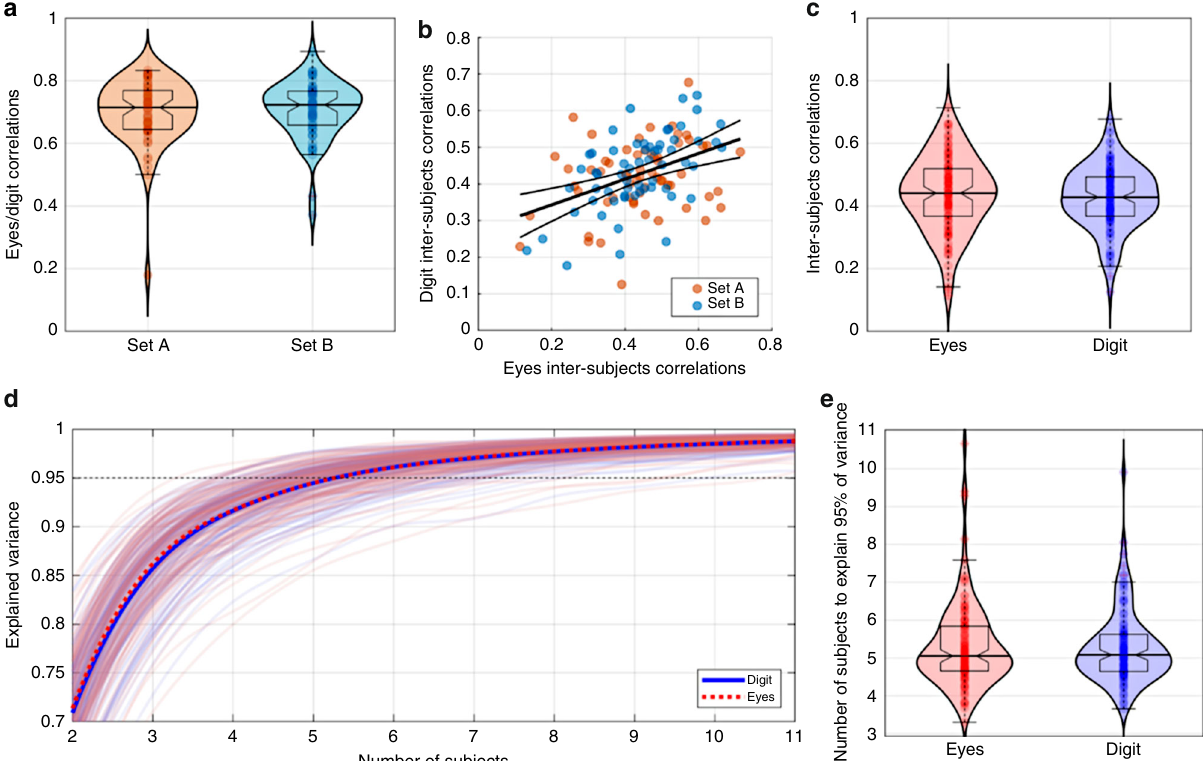
Fig. 2 Digit and eye-tracking comparison. A total of 122 pictures featuring humans, animals, objects or abstract art were divided in two sets (Set A and Set B). Half of the subjects explored Set A using digit-tracking and Set B with eye-tracking, while the other half explored Set B using digit-tracking and Set A using eye- tracking, thus yielding two independent sets of attention maps for each method. a Violin plots of the Pearson ’ s correlation coef fi cients calculated, for each picture, between the probability density estimates of exploration measured with eye-tracking or digit-tracking (11 subjects/condition). Both techniques can measure precise attention maps that are highly correlated (Set A: median correlation = 0.71, sign-test p <9×10 − 19 ; Set B: median correlation = 0.72, p <9× 10 − 19 ; no signi fi cant differences between image sets: Wilcoxon p = 0.72). b , c Inter-subject correlations scatter and violin plots, respectively. Inter-subject correlations were calculated, for each image/technology couple, as the average Pearson correlation coef fi cient between the exploration densities of one subject with the exploration density of another subject. ISC calculated with eye-tracking or digit-tracking are correlated (B) ( r = 0.42, p <2×10 − 6 ). No signi fi cant differences can be found for ISC between explorations measured with eye-tracking or digit-tracking ( c ) (median eyes = 0.44, median digit = 0.43, Wilcoxon p = 0.32). d Convergence of exploration normalized density estimates. Each curve represents for one image/technology couple recorded with N subjects, the percent of variance of the exploration normalized density estimates that could be explained with N-1 subject. e Violin plots of the number of subjects necessary to explain more than 95% of variance. Eye-tracking and digit-tracking show similar performances (median = 5, seven subjects are suf fi cient to obtain stable measurements on most